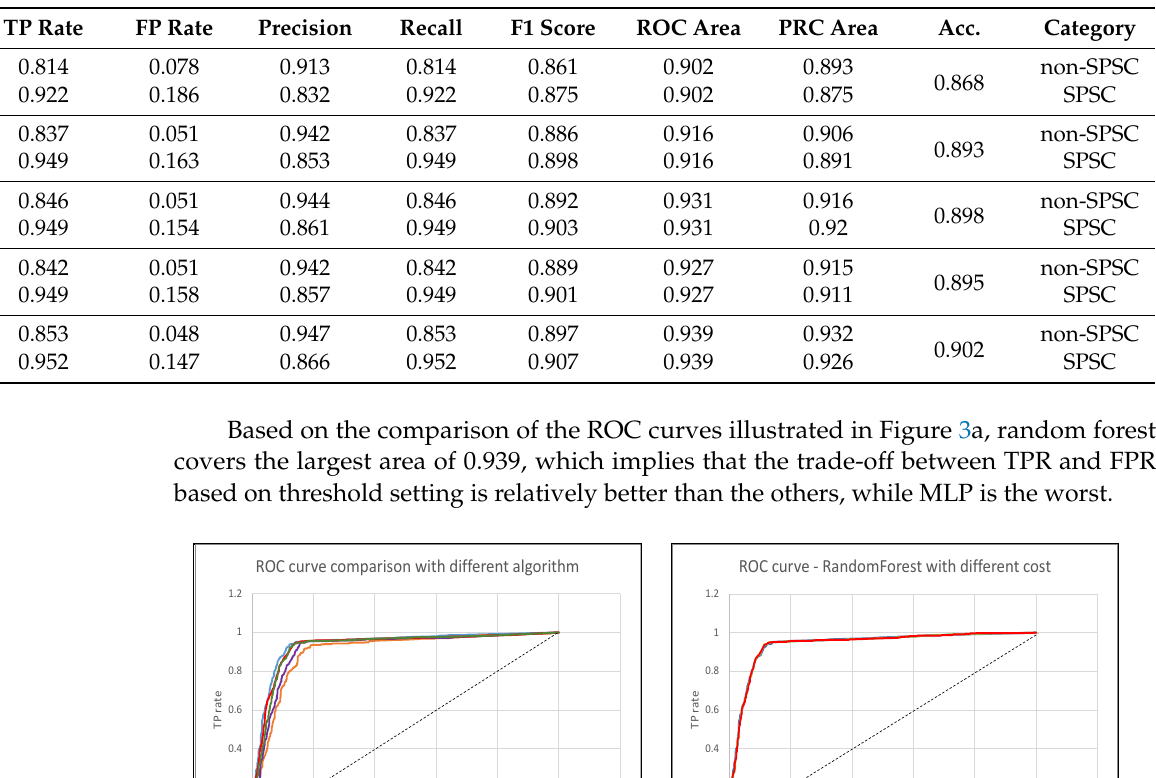
Table 2. Comparison of the classification performance for different algorithms.